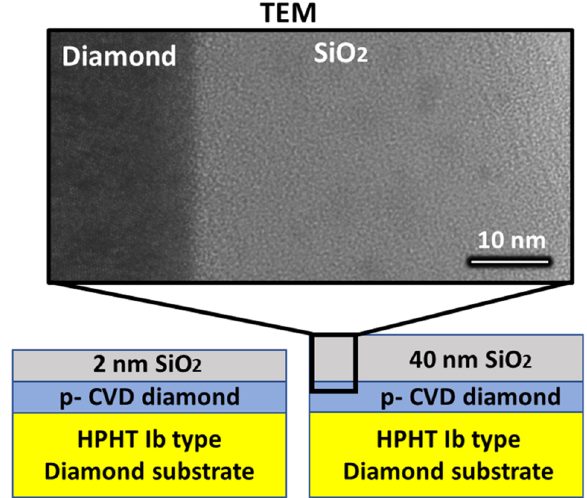
Figure 1. Scheme of the two analysed samples. The samples consist of silicon oxide layers of 2 nm and 40 nm deposited by ALD on boron-doped MPCVD diamond layers grown on High pressure high temperature (HPHT) Ib diamond substrates. A transmission electron microscopy image of the thicker 40 nm silicon oxide layer is also